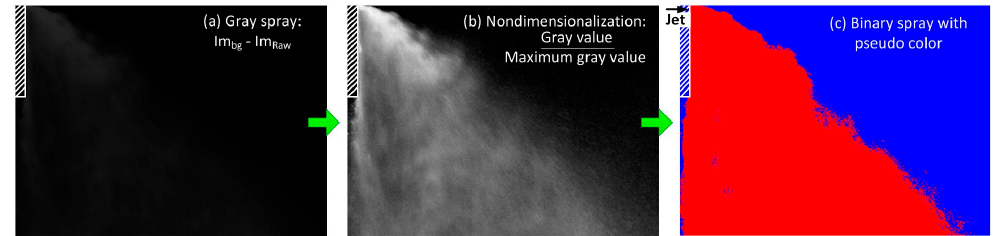
Figure 4. The typical side and front views of the spray far field [20].